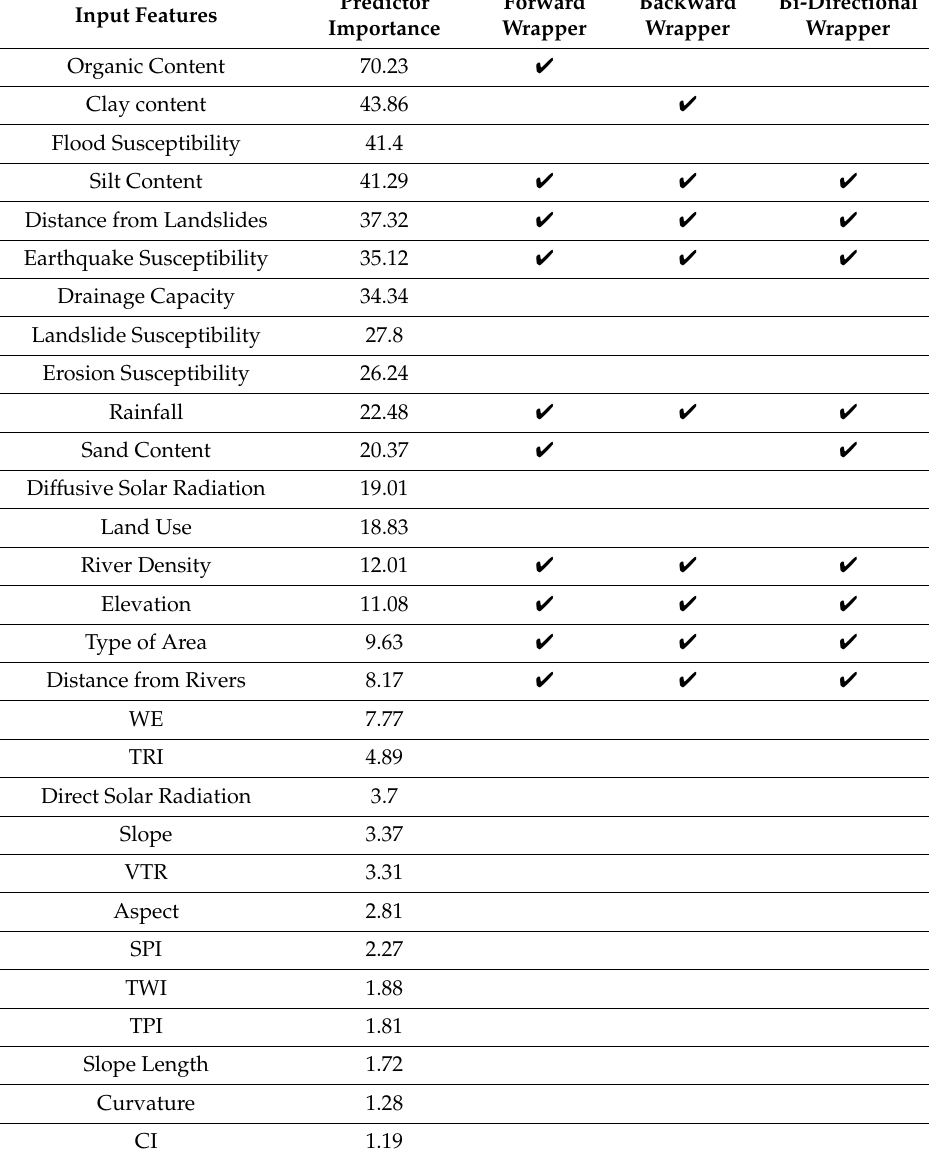
Table 6. Predictor Importance of the MLAs and comparison with wrapper